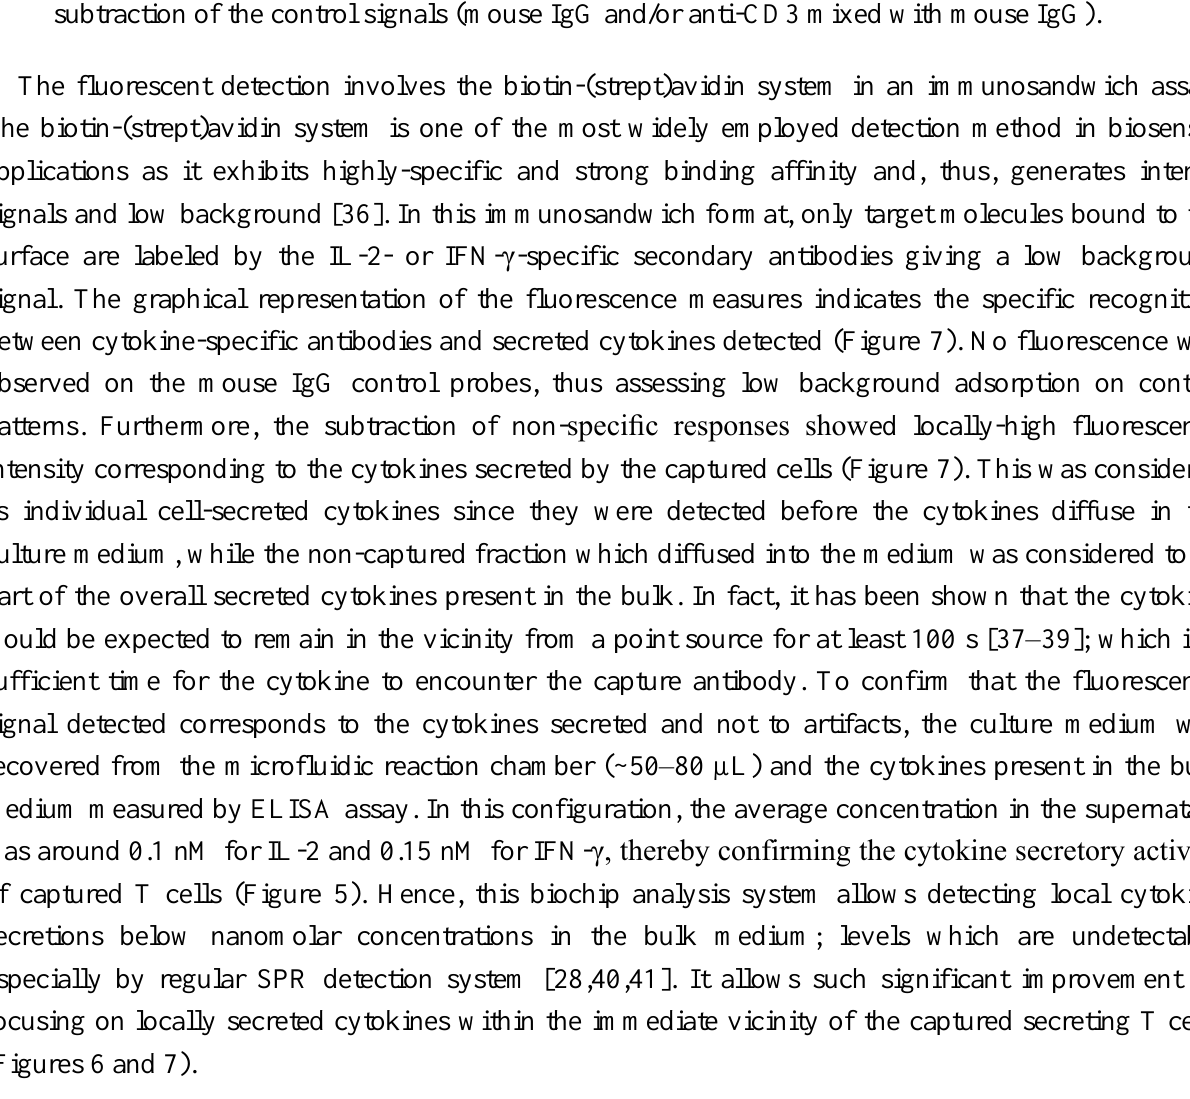
Figure 6. Continuous SPRi dual-detection of IFN-γ and IL-2 secreted by captured peripheral blood T lymphocytes. After cell injection in the microfluidic chamber and capture on their specific antibody probes (anti-CD3, mixture of anti-CD3/anti-IL-2, and anti-CD3/anti-IFN-γ), secreted cytokines are continuously detected by SPRi. Reflectivity variations of each probe are averaged and plotted upon time after rectification by the subtraction of the control signals (mouse IgG and/or anti-CD3 mixed with mouse